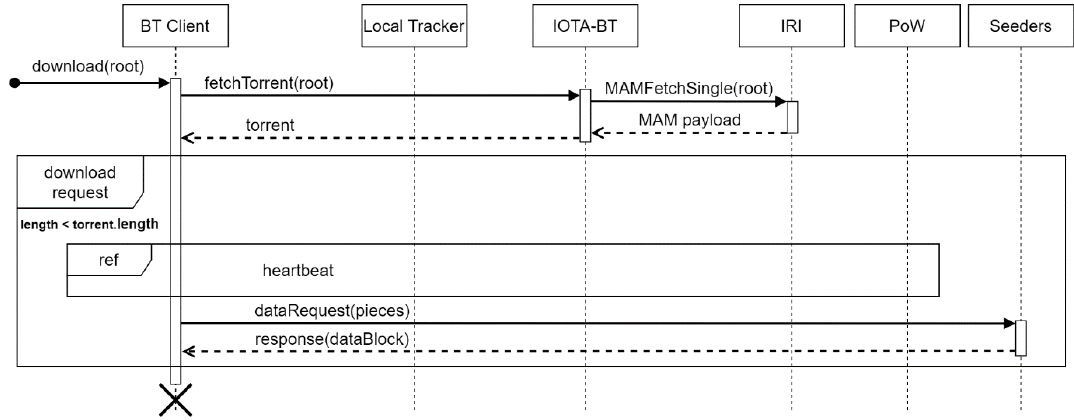
Figure 7. Download process in IOTA-BT.